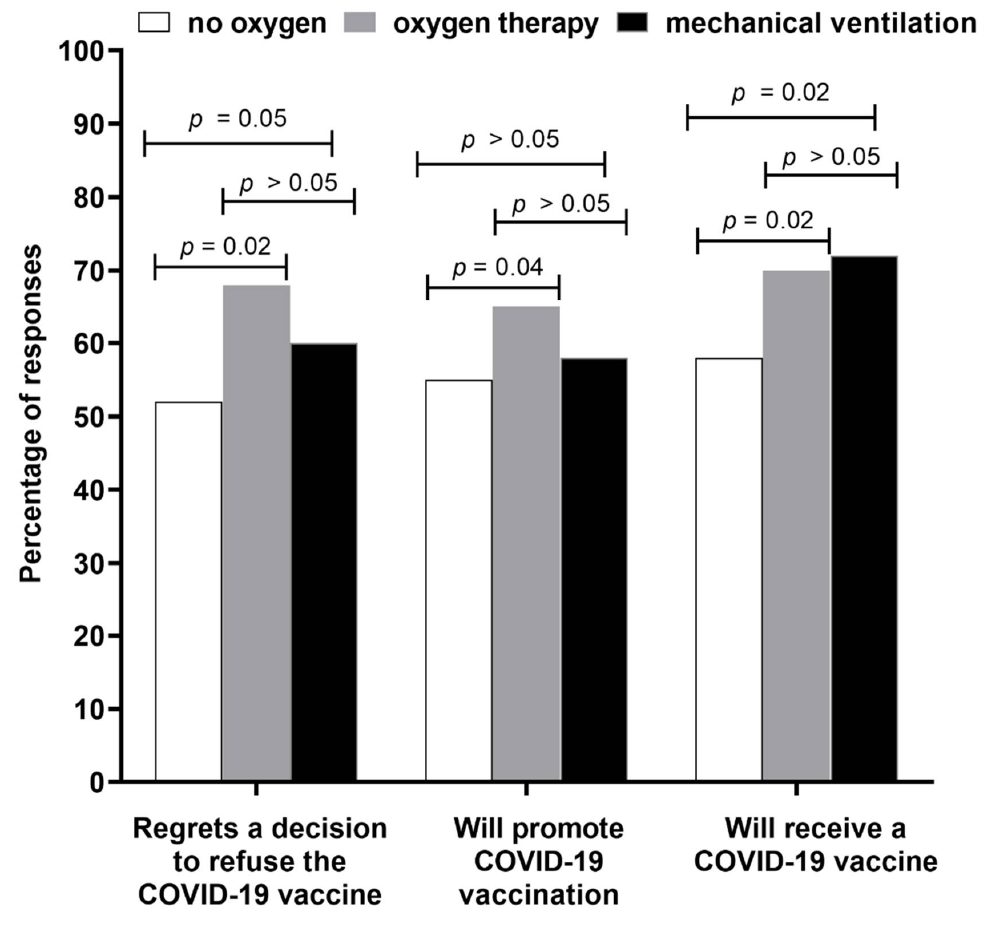
Figure 2. The frequency of various declarations made by unvaccinated hospitalized patients ( n = 730) in relation to the clinical severity of COVID-19.